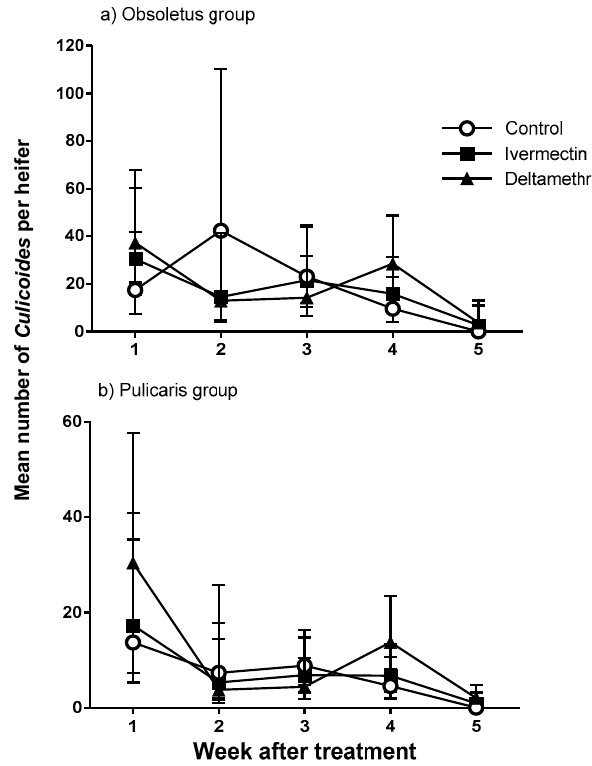
Figure 3. Mean number ( ± 95% confidence intervals) of female Culicoides for ( a ) Obsoletus group and ( b ) Pulicaris group captured on white sticky traps, mounted on the backs of Friesian heifers treated with deltamethrin, ivermectin and untreated control ( n = 5) and released onto open pasture for 24 h, 1–5 weeks after treatment. Data are back-transformed from generalised linear mixed model (GLMM) predictions.